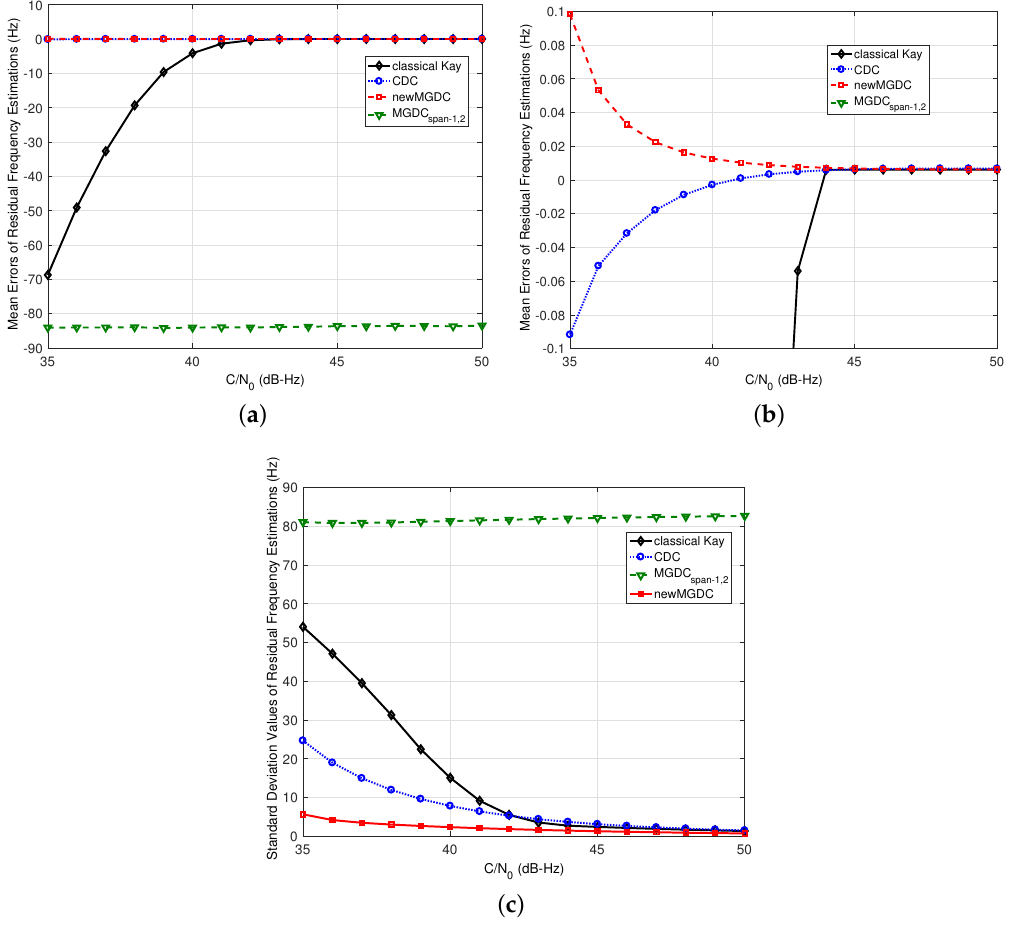
= 250 Hz, T = 1 ms, coh d